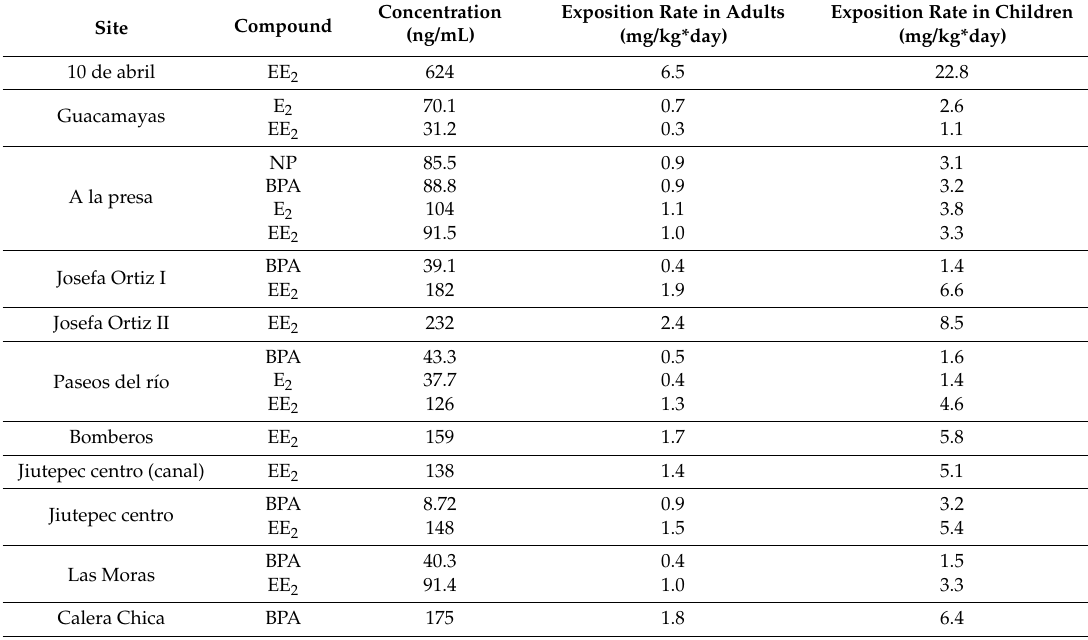
Table 4. Health risk rate for exposition to